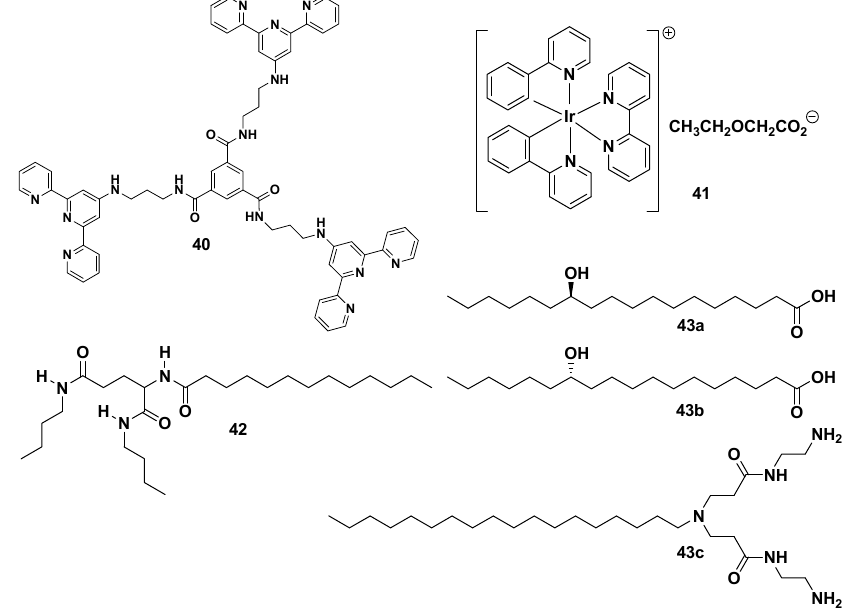
Figure 10. TEM images of metal oxide/TiO 2 hybrid nanotubes ( a – d : Zr, e – h : Nb, and i – l : Si). Ti:Zr = 9:1 ( a ); 8:2 ( b ); 7:3 ( c ) and 6:4 ( d ); Ti:Nb = 9:1 ( e ), 8:2 ( g ) and 6:4 ( h ); Ti:Si = 9:1 ( i ), 8:2 ( j ), 7:3 ( k ) and 6:4 ( l ). Scale bars are 0.2 μ m. Reproduced from Reference